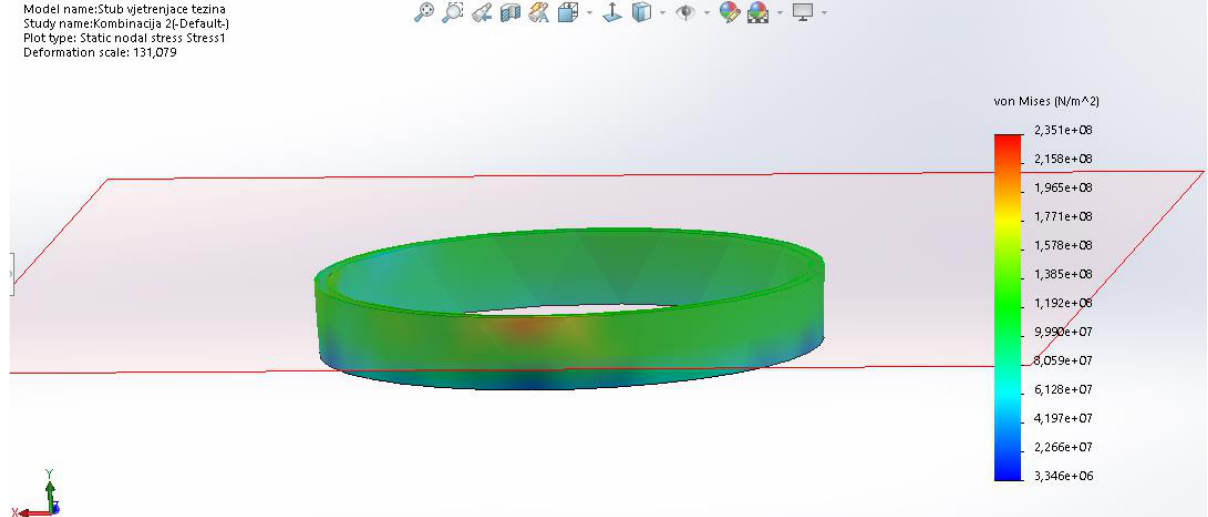
Figure 7. Magnitude and position of maximum